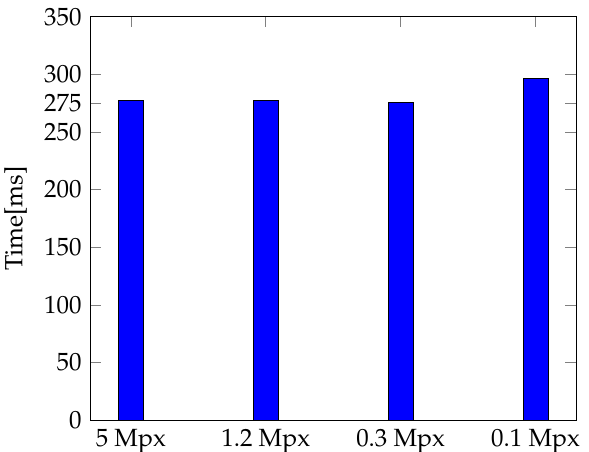
Figure 12. Average processing time of a single bee picture for different